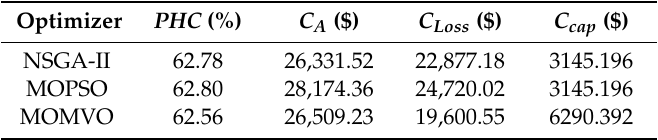
Table 9. Probabilistic results for the 59-node distribution system.